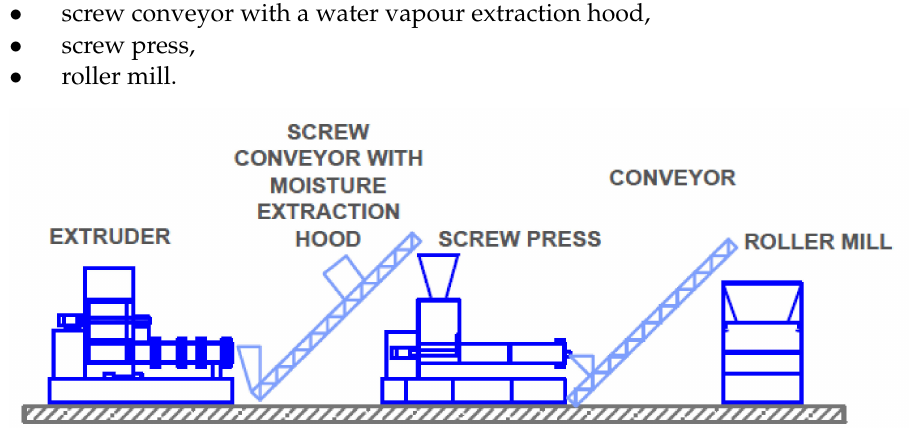
Figure 1. A full-fat soybean processing